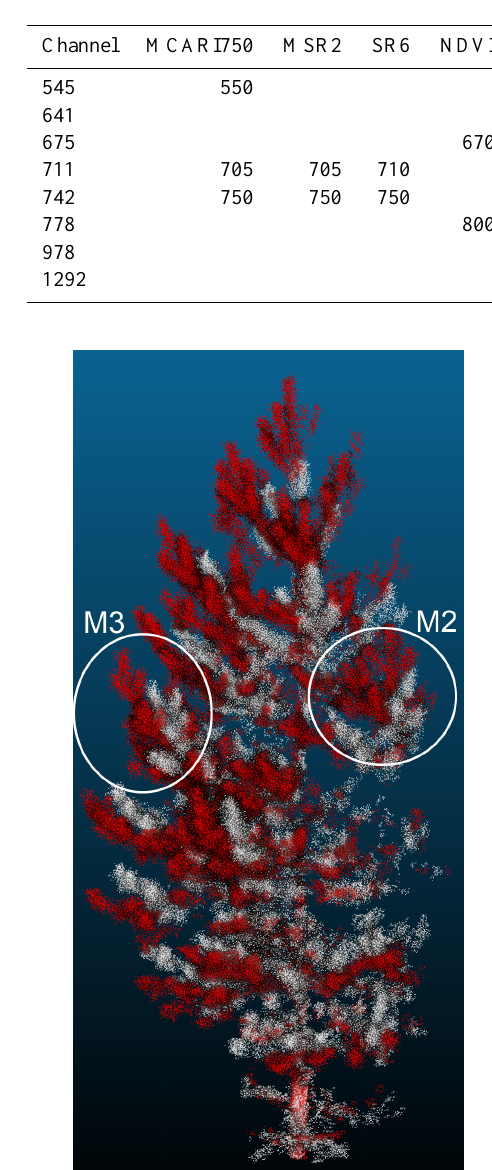
Table 1. The available channel wavelengths (nm) and the nomi- nal wavelengths (nm) of the spectral indices. The closest available channel was used.